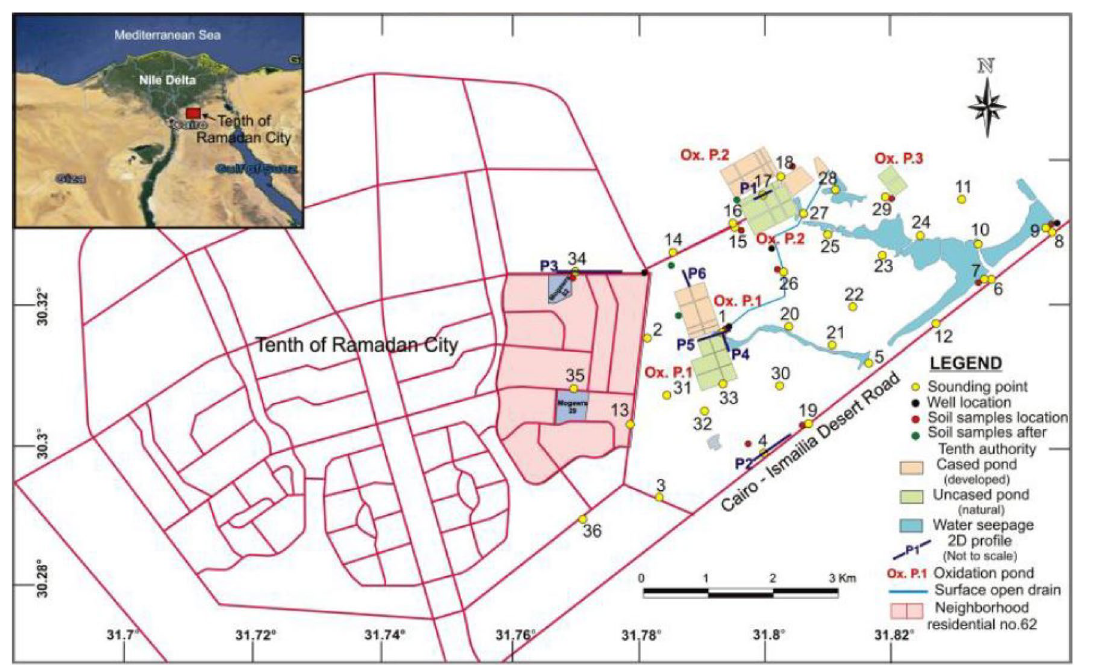
Fig. 1 Location map of 10th of Ramadan city, including the oxidation ponds 1, 2 and 3. (Attwa et al.